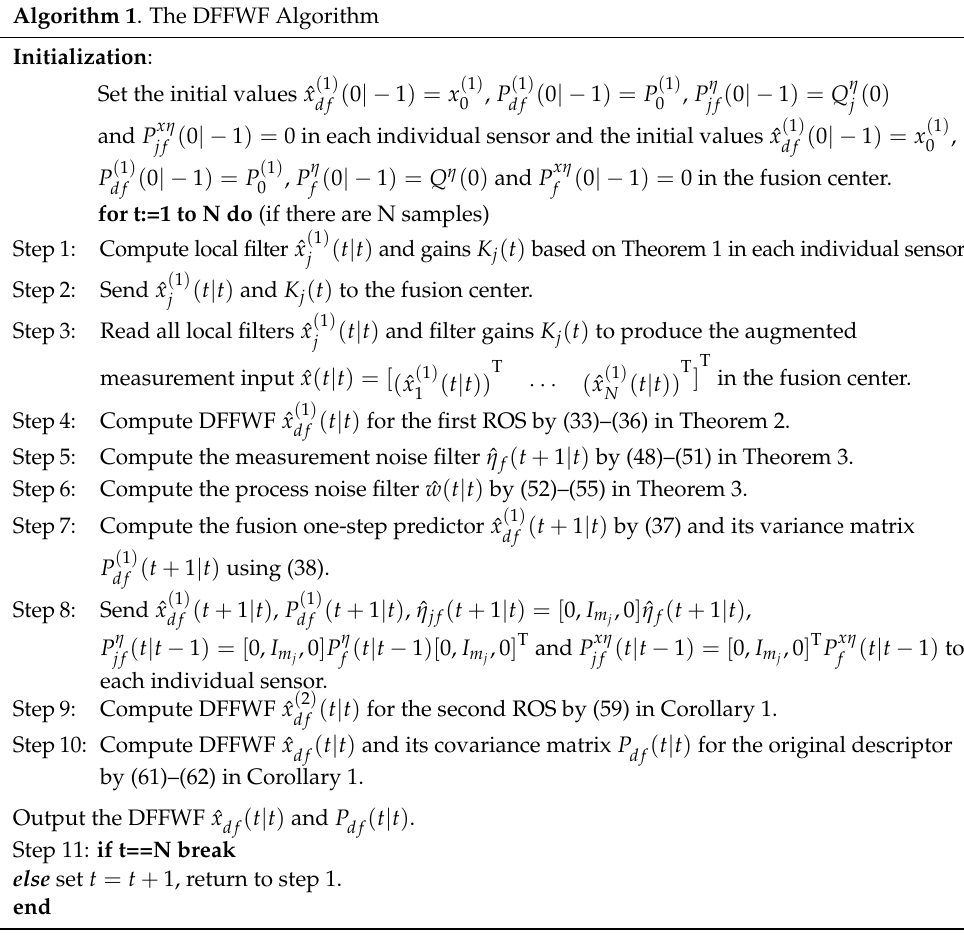
Algorithm 1 . The DFFWF